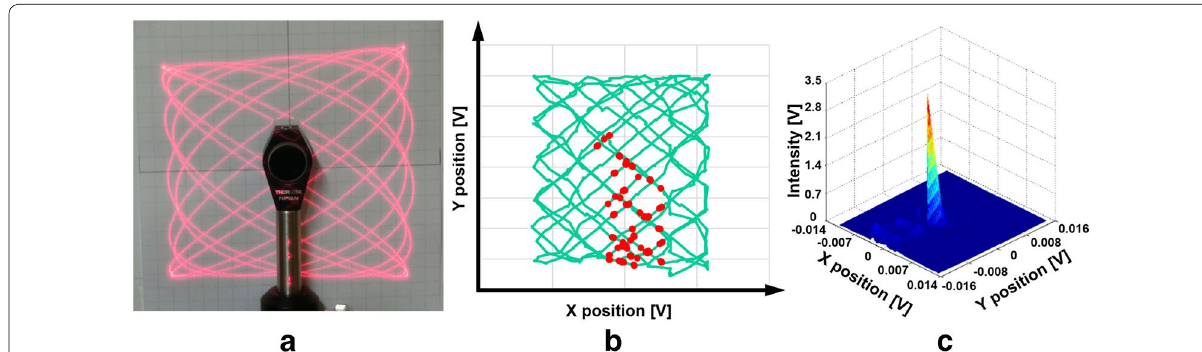
Fig. 6 Position and intensity measurement result: a mirror position inside the scan pattern, b reconstructed scan pattern and intensity measurement points, c intensity of the reflected beam vs. xy position